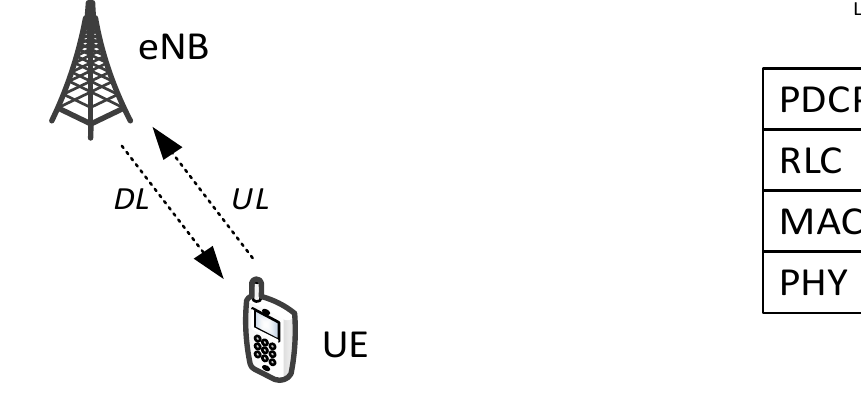
Figure 1. LTE-A radio access network ( left ); and protocol layering ( right ).